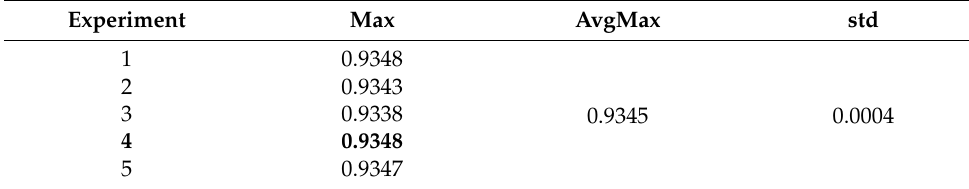
Table 8. Results varying the value of mutation probability (MutPb).